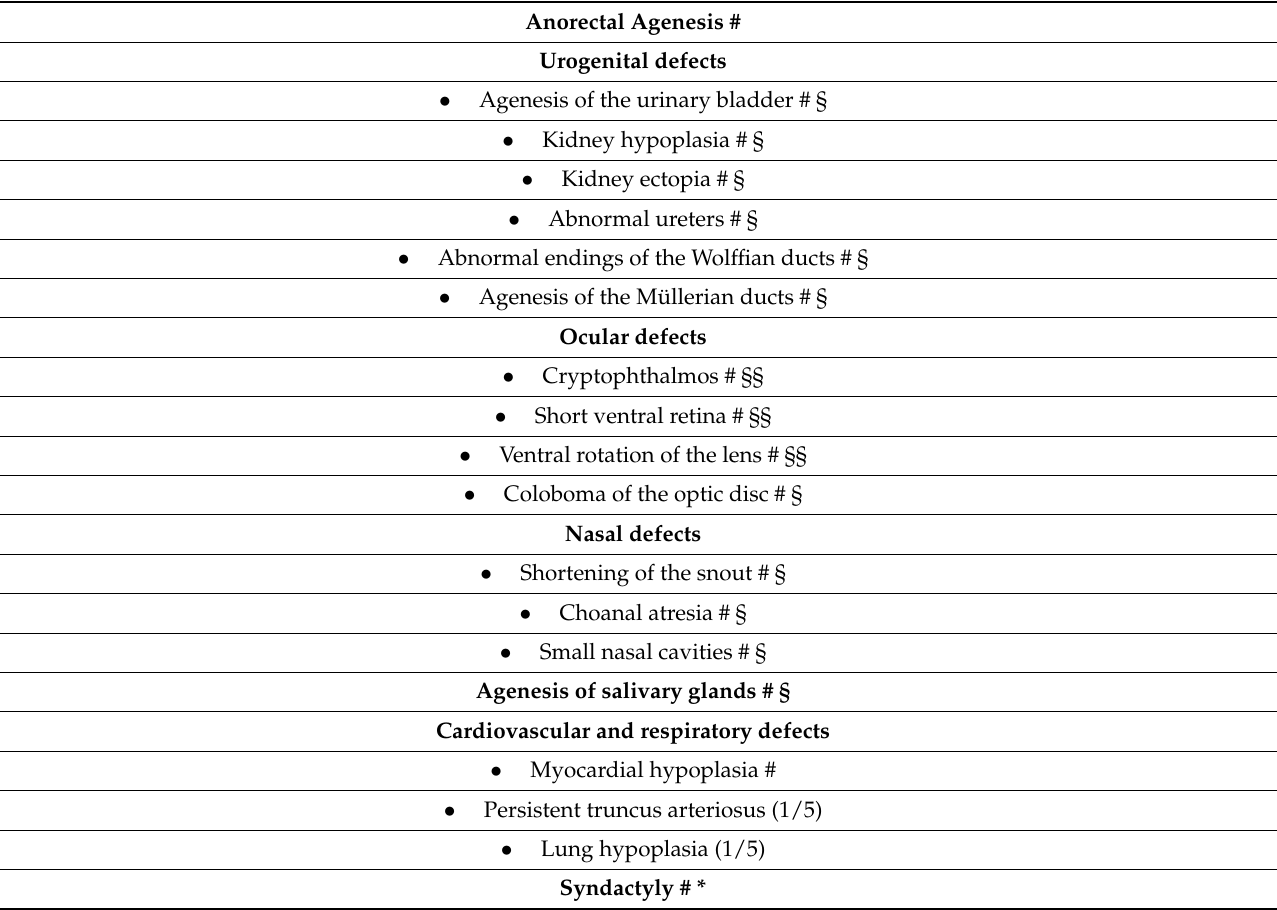
Table 1. Abnormalities displayed by Rarabg ∆ E10.5 mutants analysed at E14.5 on serial histological sections (n = 5, all females). # These abnormalities are completely penetrant. § These abnormalities equal or exceed, in frequency and eventually also in severity, those present in Rara − / − ; Rarb − / − , Rara − / − ; Rarg − / − and Rarb − / − ; Rarg –/– KO mutants and are not observed in Rarabg ∆ E11.5 mutants. §§ These abnormalities equal or exceed, in frequency and eventually also in severity, those present in Rara − / − ; Rarb − / − Rara − / − ; Rarg − / − and Rarb − / − ; Rar − / − KO mutants and are also observed in a milder form in Rarabg ∆ E11.5 mutants. * This abnormality is completely penetrant and is as severe in Rarabg ∆ E11.5